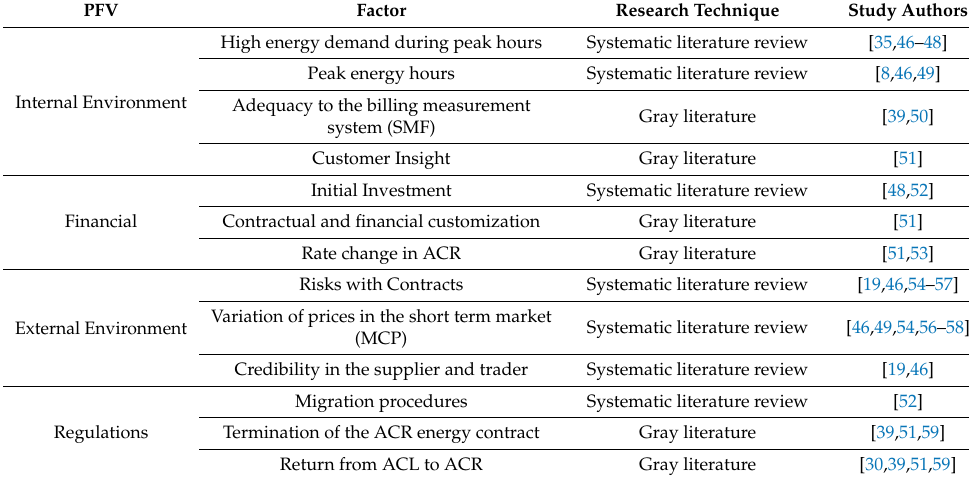
Table 3. Determinant factors for migration from Regulated Contracting Environment (ACR) to Free Contracting Environment (ACL) extracted from the systematic literature review and gray literature. PFV